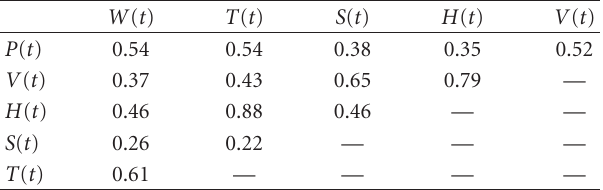
Table 1: Estimated P -values of S 3 using 100 simulations for testing the separability of each of the weather covariates in model (1). P ( t ), V ( t ), H ( t ), S ( t ), T ( t ), and W ( t ) represent precipitation, mean visibility, mean humidity, mean sea level pressure, mean temperature, and mean wind speed, respectively, for day t .